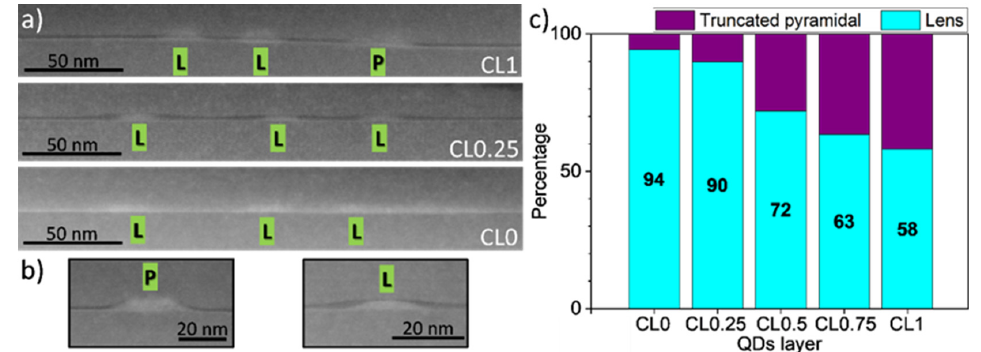
Figure 2. ( a ) LAADF images of the layers CL1 (top), CL0.25 (middle) and CL0 (bottom). Lens and pyramidal-shaped dots are marked with L and P, respectively. The Al-rich CLs appear darker. ( b ) Zoom of a truncated pyramidal (left) and lenticular (right) QD capped with AlAs. ( c ) The proportion of lenticular and pyramidal QDs in the QD population for the different QDs layers.